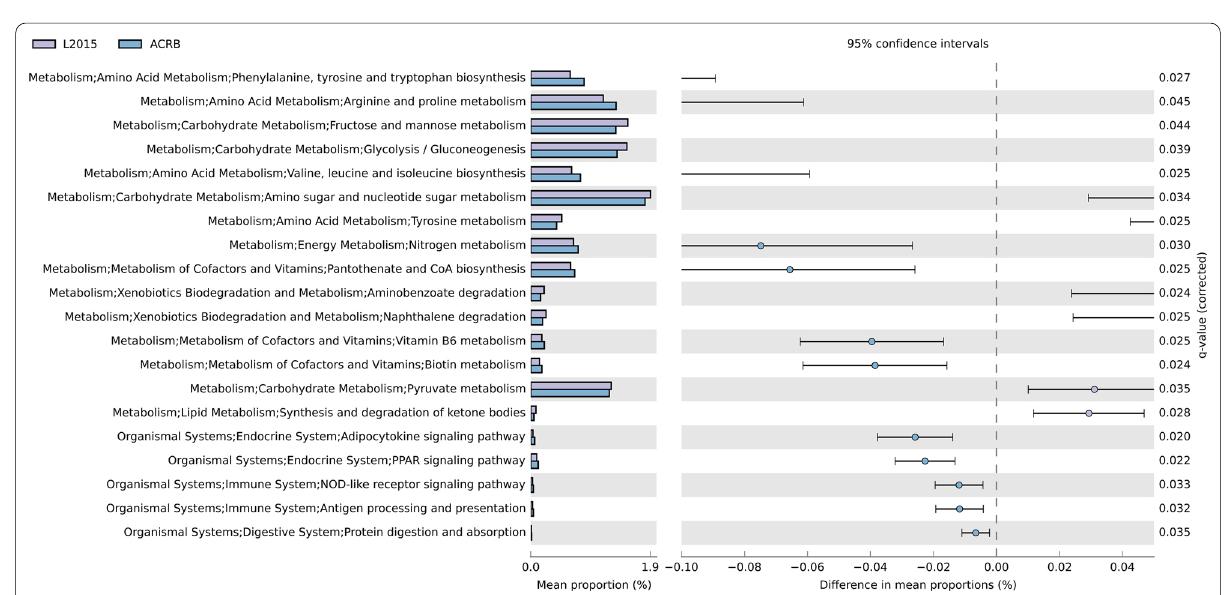
12/genetic line) =